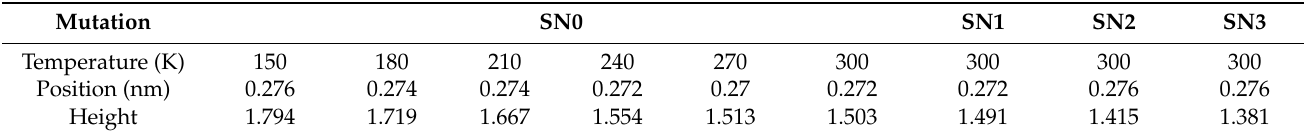
Figure 4. The nitrogen atom on W140 was centered and water oxygen atoms were calculated for RDF in different conditions: ( a ) the RDF of SN0 at 150 K, 180 K and 300 K. ( b ) the RDF of native SN0 and mutation SN3 at 300 K. ( c ) the relationship between the ratio of g(r)min/g(r)max to SN0 and temperature. Parts of the data (the native at 210 K, 240 K, 270 K and mutations SN1, SN2 at 300 K) are not plotted to avoid overlap among curves. Table 3. The value of the first peak of RDF in each